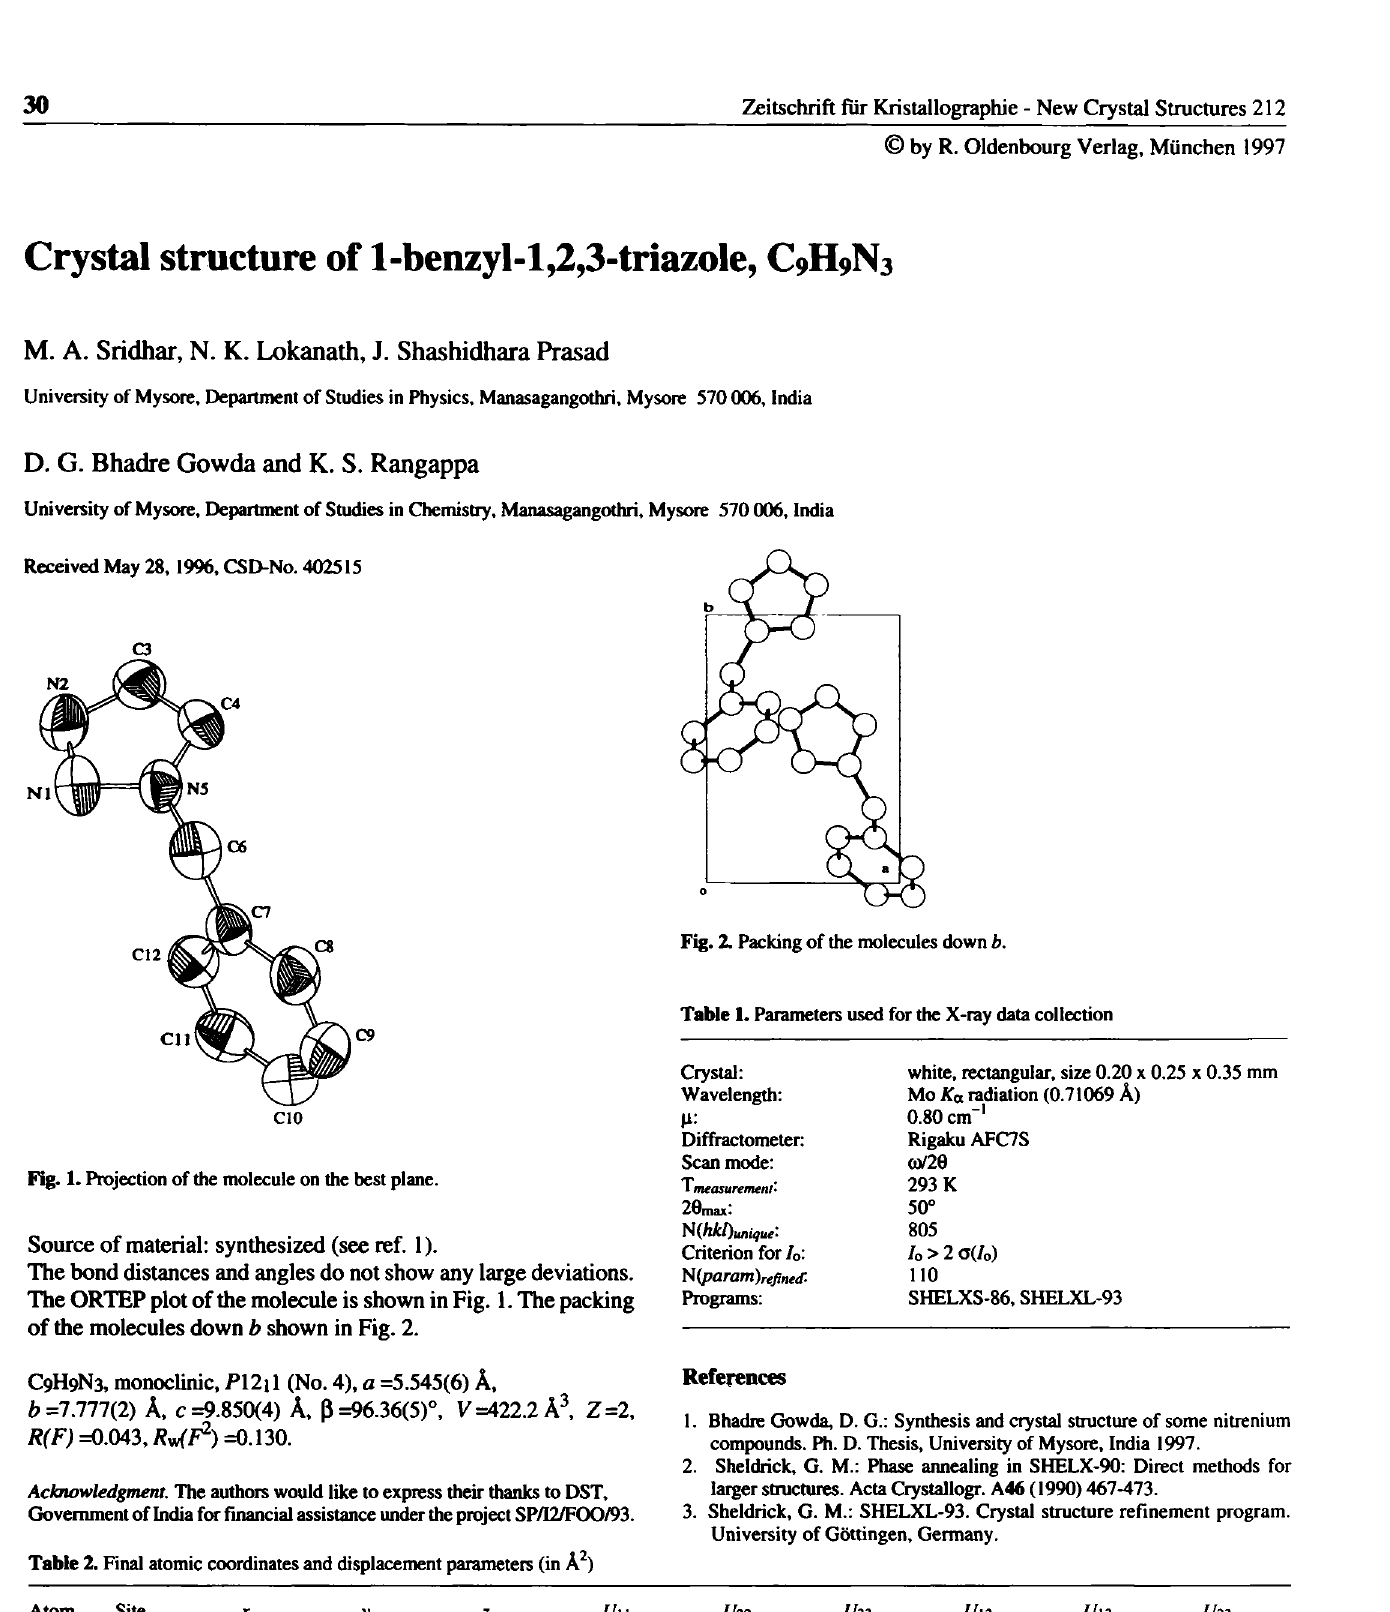
Table 2. Final atomic coordinates and displacement parameters (in Â 2 )